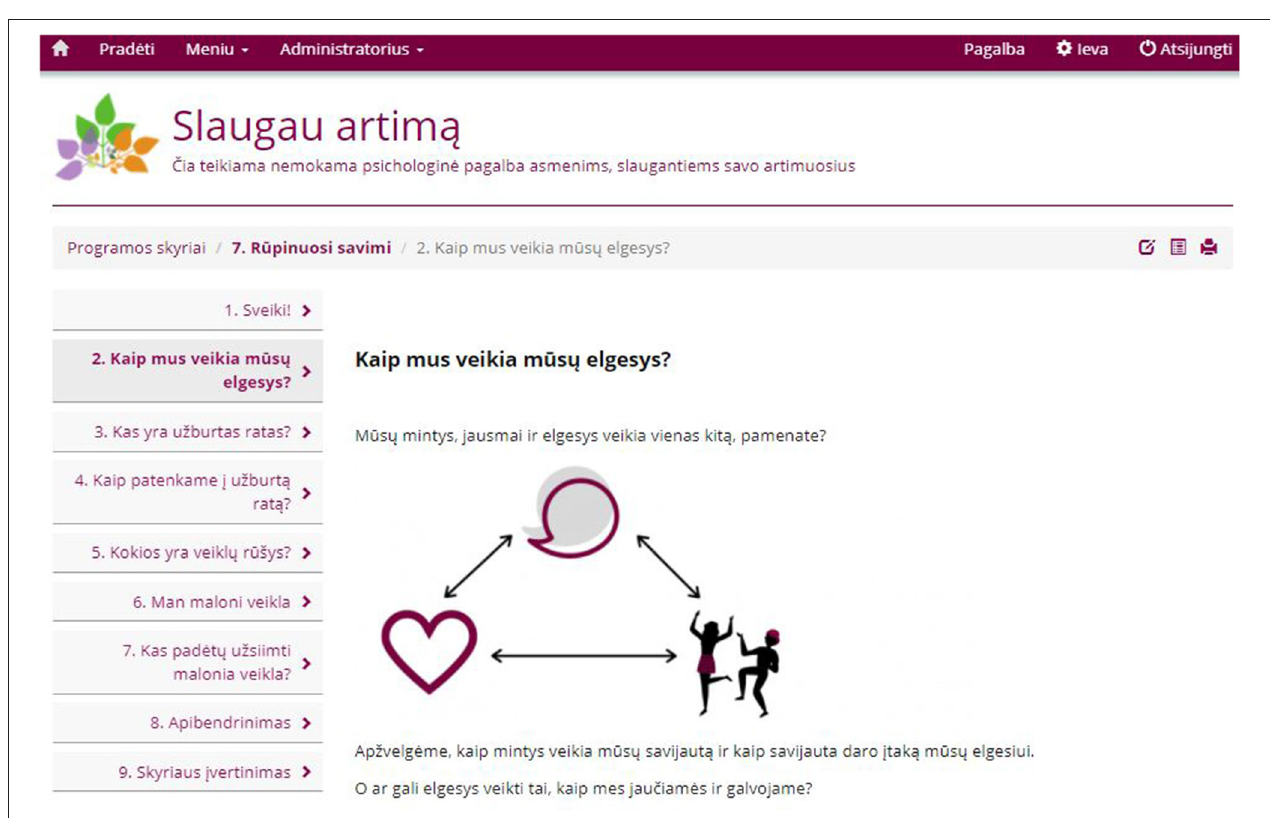
FIGURE 3 | Sample of the intervention’s content. On the left side, users can move from tab to tab to access modules materials (Starting with 1. Sveiki! ).